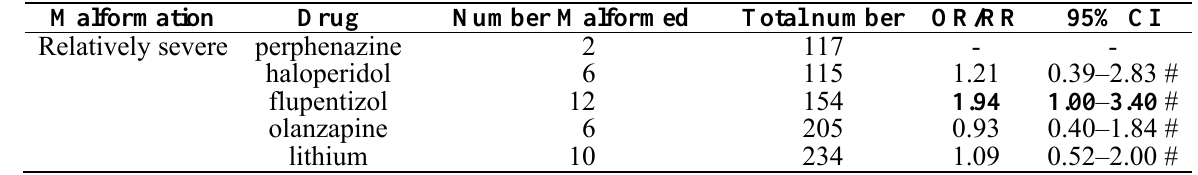
Table 20. “Relatively severe malformations” after maternal use of five neuroleptics with at least 100 exposures. Bold text marks statistical